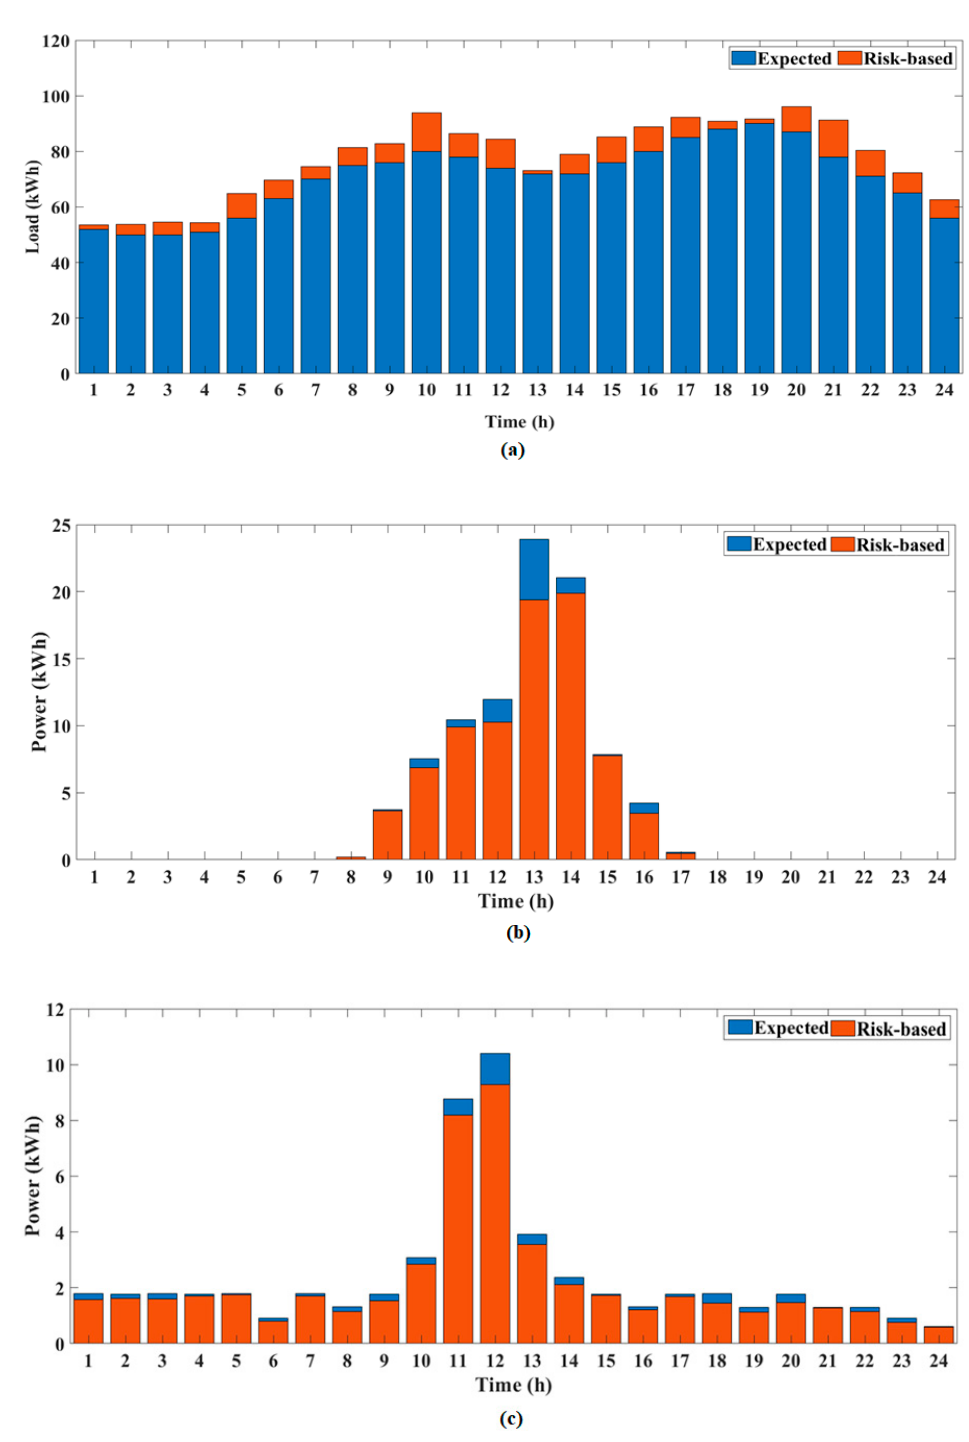
Figure 7. Expected and risk-based volumes. ( a ) Load, ( b ) photovoltaic (PV) generated, and ( c ) wind turbine (WT) generated.